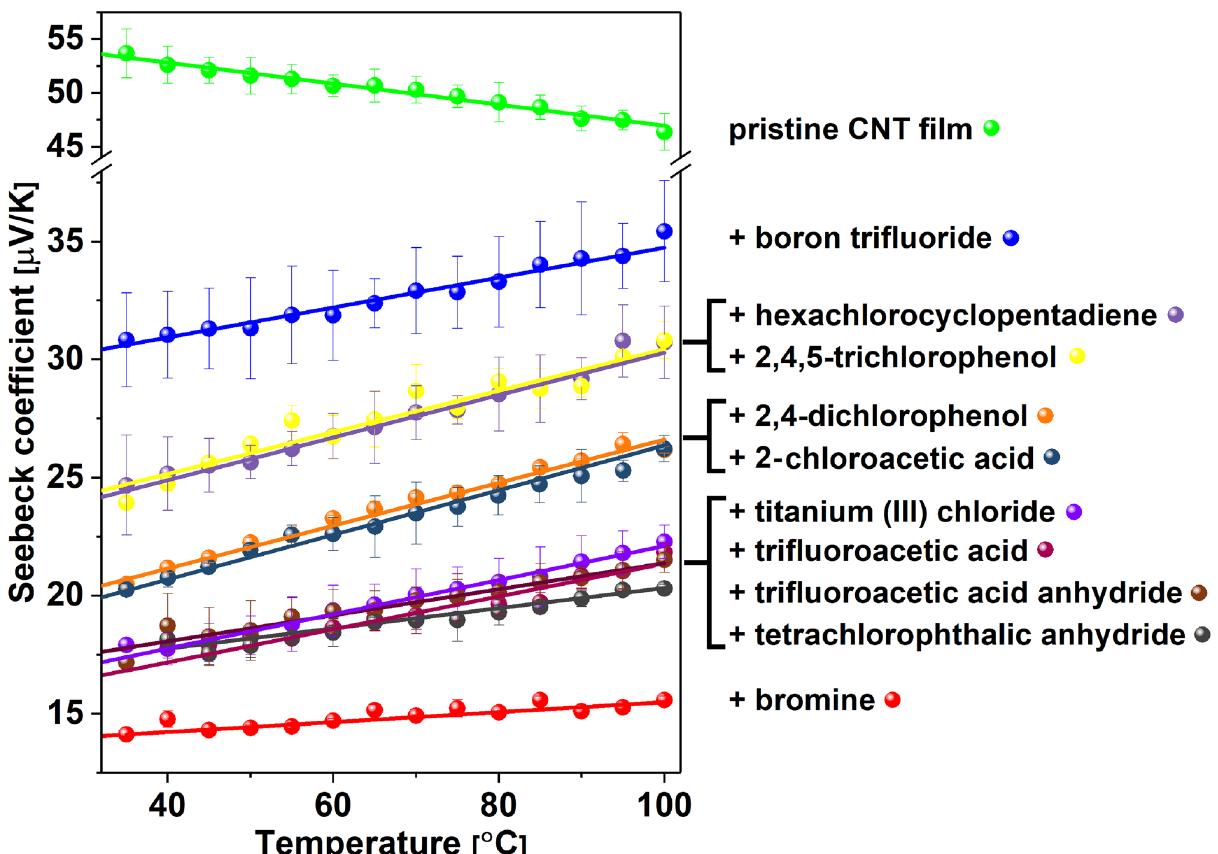
Figure 5. Seebeck coefficient at different temperatures for a pristine CNT film and CNT films after doping with halide compounds. Lines were added to guide the eye through a selected group of